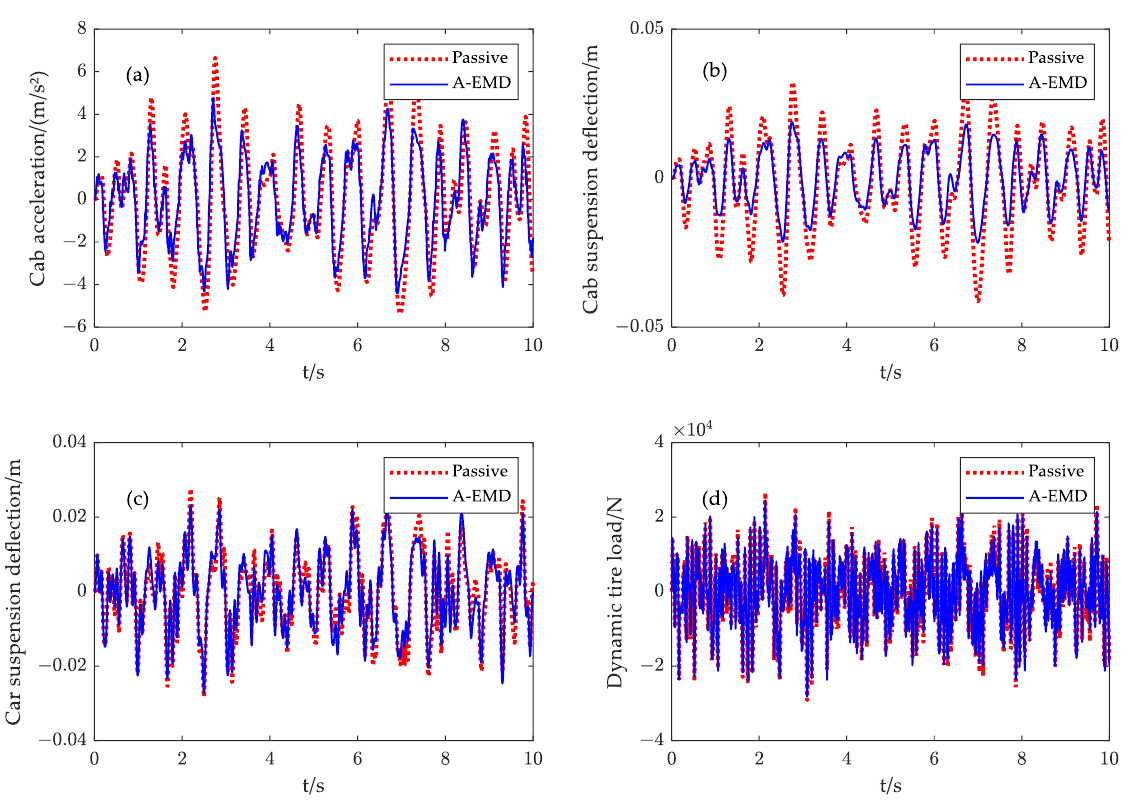
Figure 11. Response under random road excitation: ( a ) cab acceleration; ( b ) cab suspension deflection; ( c ) car suspension deflection; ( d ) dynamic tire load.